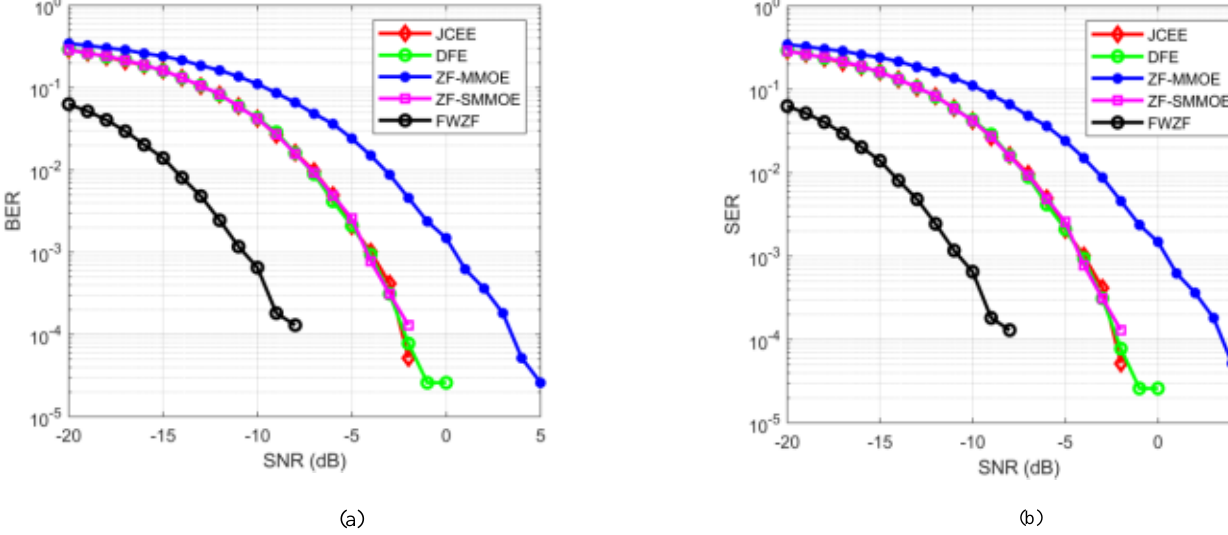
Fig. 3. Comparative analysis using antenna=4 in Rician channel, (a) BER, (b)